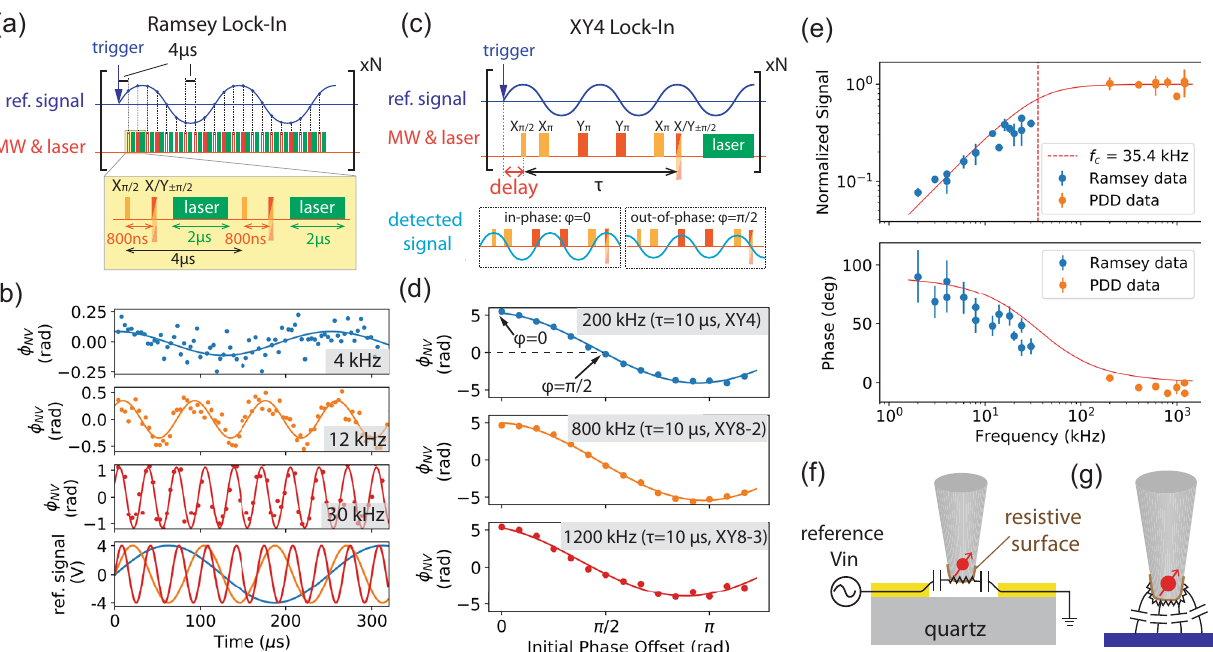
Fig. 2 Frequency dependence of the electric fi eld screening effect. a Top panel: Ramsey-based lock-in detection sequence used at low frequencies. A train of Ramsey measurements is synchronized with the external reference signal, and samples the local electric fi eld every 4 μ s. Bottom panel: Zoom-in of two Ramsey sequences. b Top three panels: Time traces of the Ramsey phase signal ϕ NV at reference frequencies of 4, 12, and 30 kHz, respectively. Bottom panel: The reference input with the aforementioned frequencies). Dynamical-decoupling-based lock-in detection at high frequencies. XY-4 sequence is shown as an example. The NV phase signal ϕ NV is maximized when the detected fi eld is in- phase with XY-4 (lower left plot), and minimized when out-of-phase by π /2 (lower right plot). d NV phase signals ϕ NV at 200, 800, and 1200 kHz. No discernible frequency dependence is observed. Pulse sequences see Supplementary Fig. 6. e Frequency dependence of signal attenuation (top panel) and phase delay (bottom panel), extracted from the lock-in measurements in b and d ). Signal is normalized with respect to the expected phase induced by the applied electric fi eld in the absence of screening. The red solid traces represent an ideal high- pass fi lter with a cut-off frequency of 35.4 kHz. PDD stands for periodic dynamical decoupling 58 , which refers to XY pulse sequences used at high frequencies. Error bars represent standard deviations estimated from sinusoidal curve fi tting. f A high-pass fi lter circuit model. NV is positioned within a metal gap. g A phenomenological circuit model showing capacitive coupling between the diamond surface and a